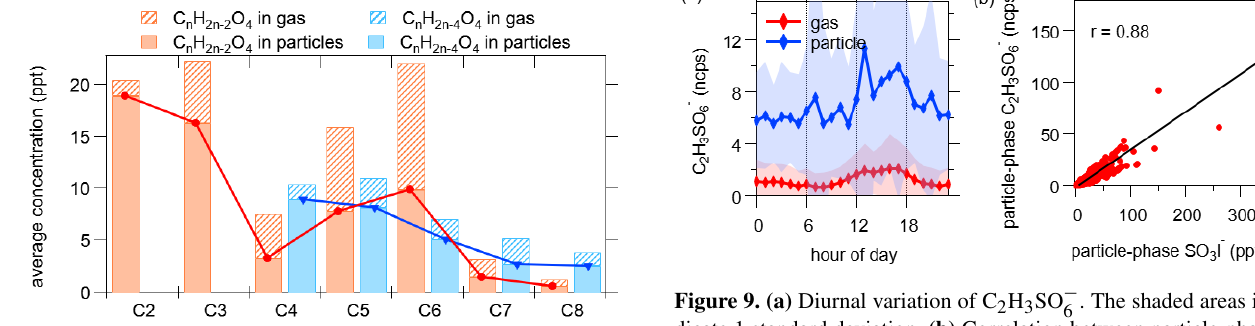
. The shaded areas in- 6